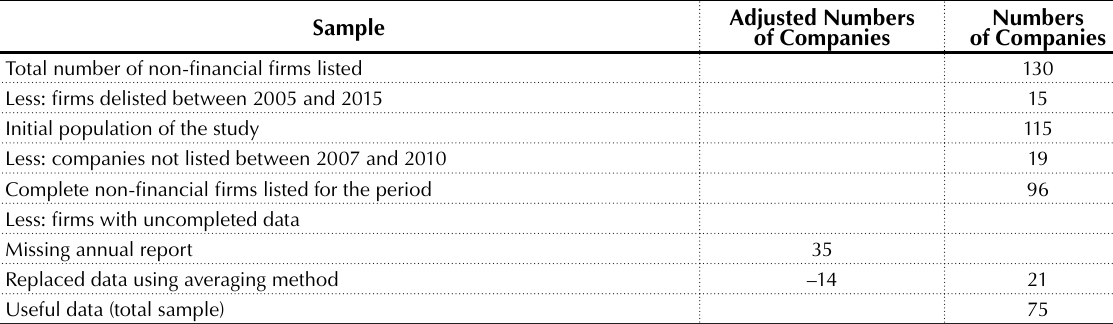
Table 1. Sample selection